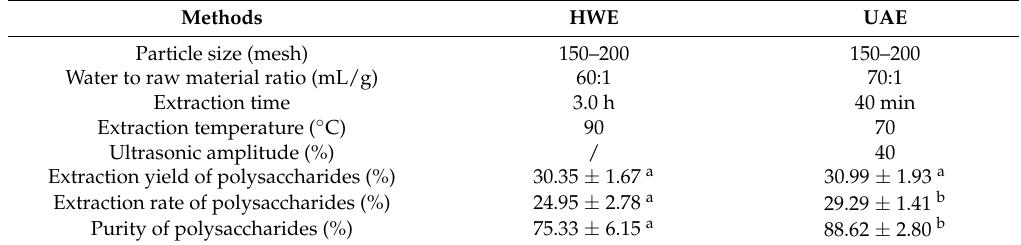
Note: Different letters in row indicate significant differences at P < 0.05.